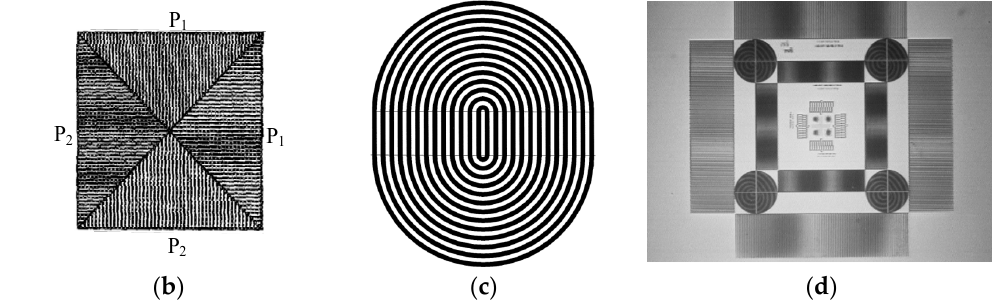
Figure 1. Generation method of aligned Moiré fringes in lithography based on physical grating. ( a ) Circular grating. ( b ) Line grating. ( c ) Elongated circular gratings. ( d ) Composite grating.